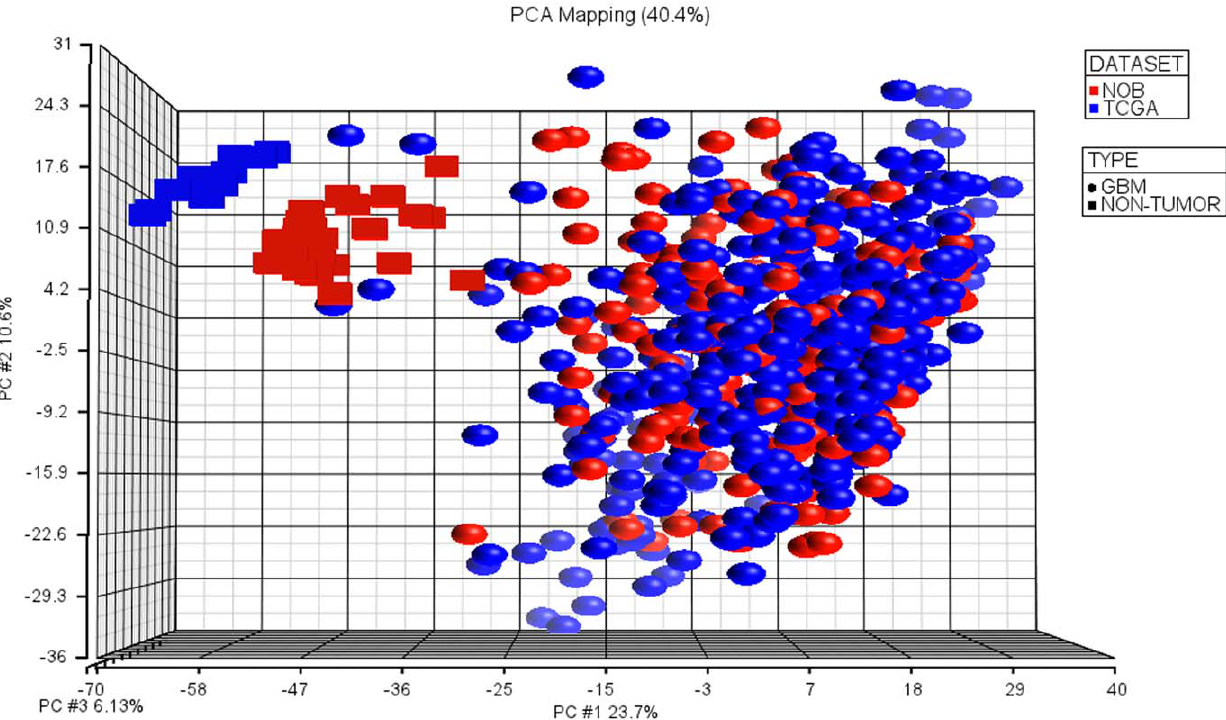
Figure 2. PCA plot of TCGA and NOB samples after batch effect removal. As expected, normal brain samples are clustered together, and TCGA and NOB samples are not separated. We used high variation 1482 probe sets (std. dev. . 1) in combined data